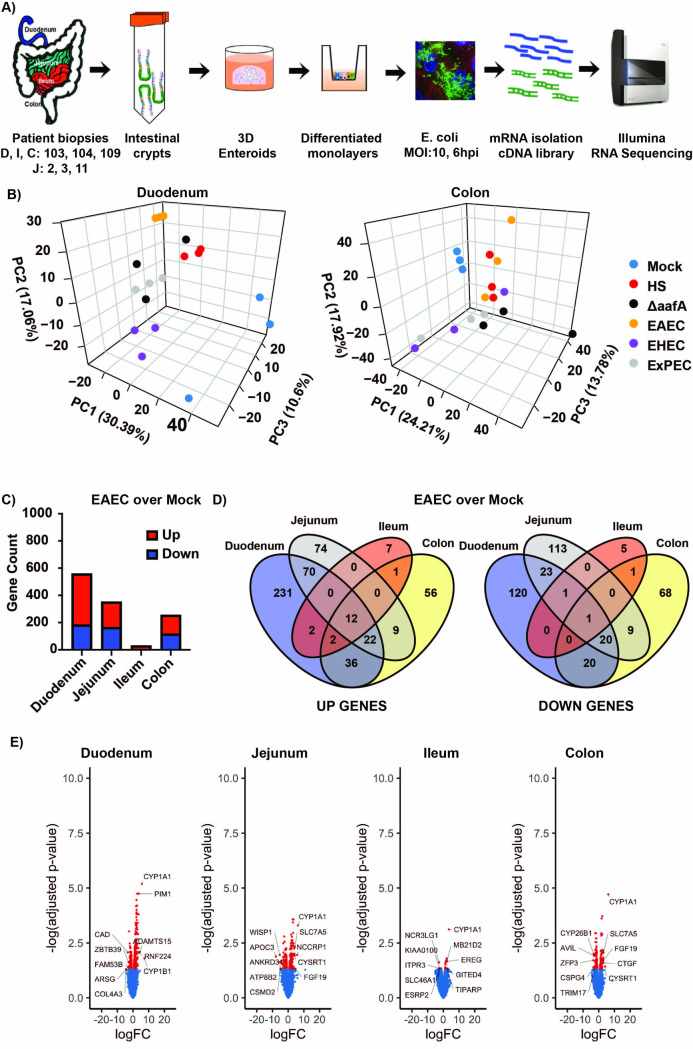
RNA sequencing analysis of pathogenic E. coli infection of human intestinal enteroid monolayers (HIEMs).(A) Experimental design and schematic representation for these experiments. (B) Principal component analysis of duodenum and colon monolayers demonstrating the variability observed in the samples (infected and mock controls). (C) Total number of significant genes identified for the EAEC infected group (BH adjusted p-value < 0.05). (D) Venn diagrams present the number of genes that are differentially expressed within the duodenum, jejunum, ileum and colon of EAEC infected samples compared to the uninfected control (E). Volcano plots of differential gene expression in each tissue for the EAEC infected samples compared to the mock infected controls. Red dots indicate genes that have an adjusted p-value of at least 0.05 with a linear fold change of at least 1.5.